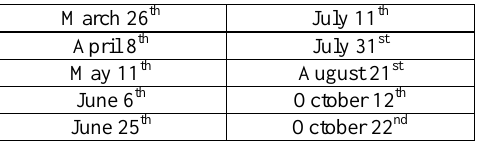
Table 1. List of cloud-free RapidEye images used in the test site Neusling during the growing season 2010.